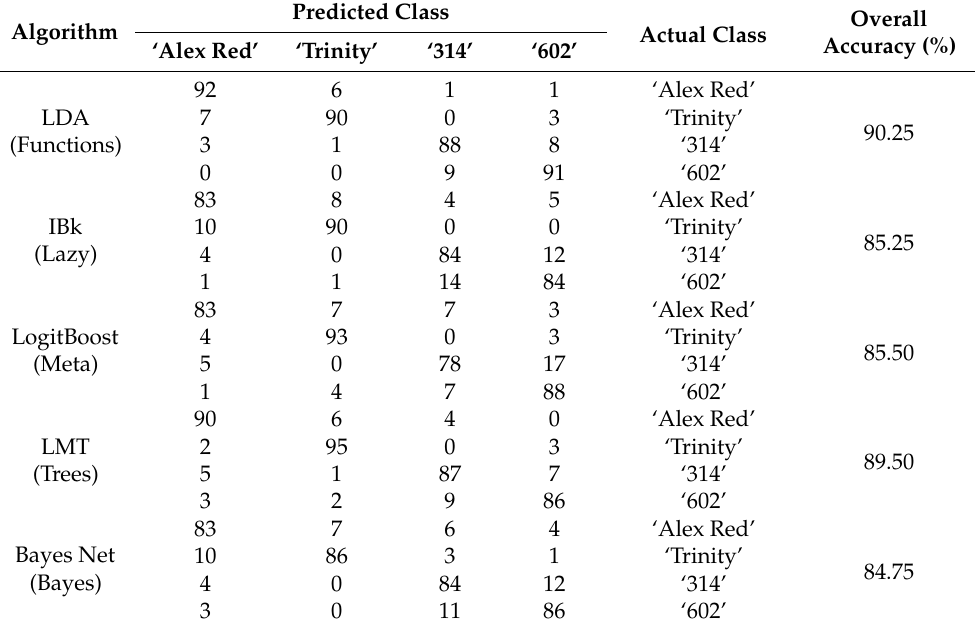
Table 2. Classification results for individual classes and overall accuracies for all classes from distinguishing freeze-dried red-fleshed apple slices based on selected texture parameters of